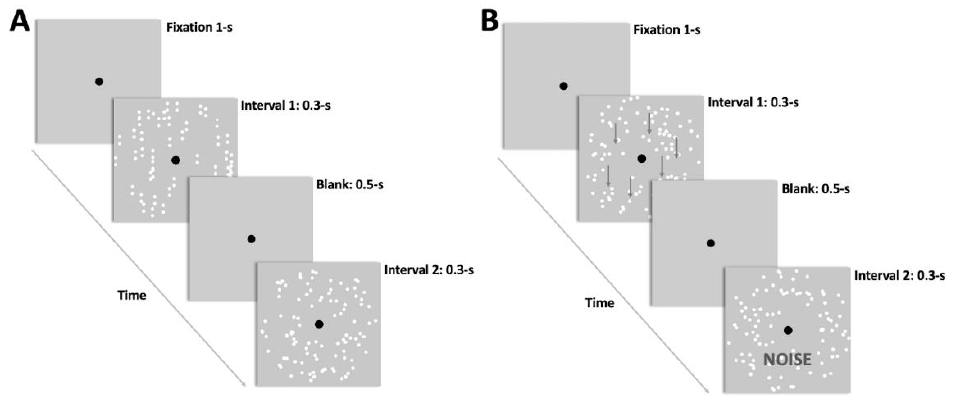
Figure 1. Schematic representation of the visual stimuli and the procedure used in the experiment. Two temporal intervals of 0.3-s each with the visual stimuli were presented after a 1-s fixation. ( A ) experimental procedure with Glass patterns (GPs), ( B ) experimental procedure with random dot kinematograms (RDKs). The first interval contains the coherent translational/vertical pattern and the second interval the random/noise pattern. However, in the experiment, this order has been randomized. In ( B ), the arrows are shown only for demonstrative purposes and were not presented during the experiment.